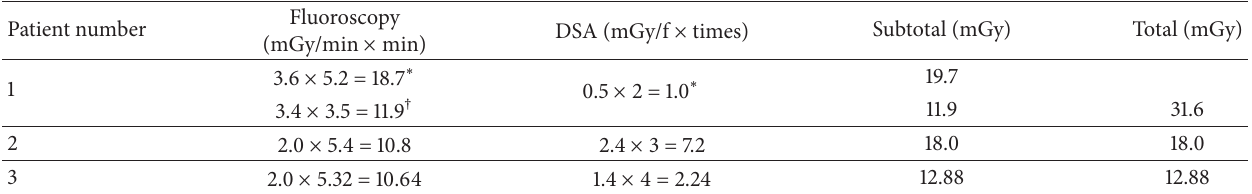
Table 5: Estimated fetal radiation dose in our patients.